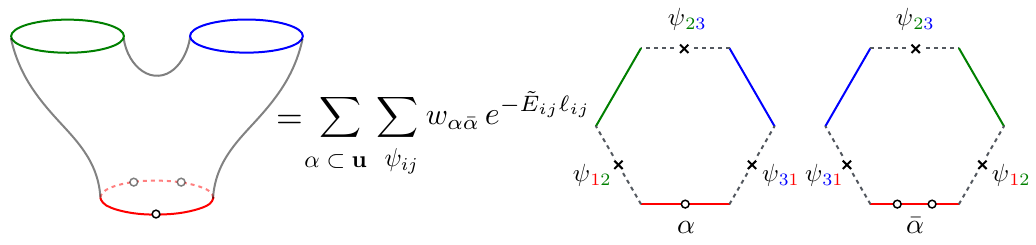
Figure 1 . A pair of pants is made of two hexagons that are stitched together along their three common edges (dashed lines). Each one of the three spin chains lying at its boundary, represented here by the three circles in the left panel, is cut open into two segments, each becoming an edge of one or the other of the two hexagons. A Bethe state is a linear superposition of magnons (seen as dots in the picture), propagating on the spin chain and interacting by means of a pairwise factorized scattering. It is uniquely characterized by the set of magnons’ rapidities u . The hexagon cutting procedure splits the state into two substates, j u i = P w (cid:11) (cid:22) (cid:11) j (cid:11) i (cid:10) j (cid:22) (cid:11) i , with each half living (cid:11) [ (cid:22) (cid:11) = u on one hexagon and with the two halves being entangled with an appropriate Bethe wave function w (cid:11) (cid:22) (cid:11) , see [20, 22]. Gluing the hexagons back together along the dashed line ij , stretching between the spin chains i and j , amounts to summing over a basis of so called mirror states ij of the